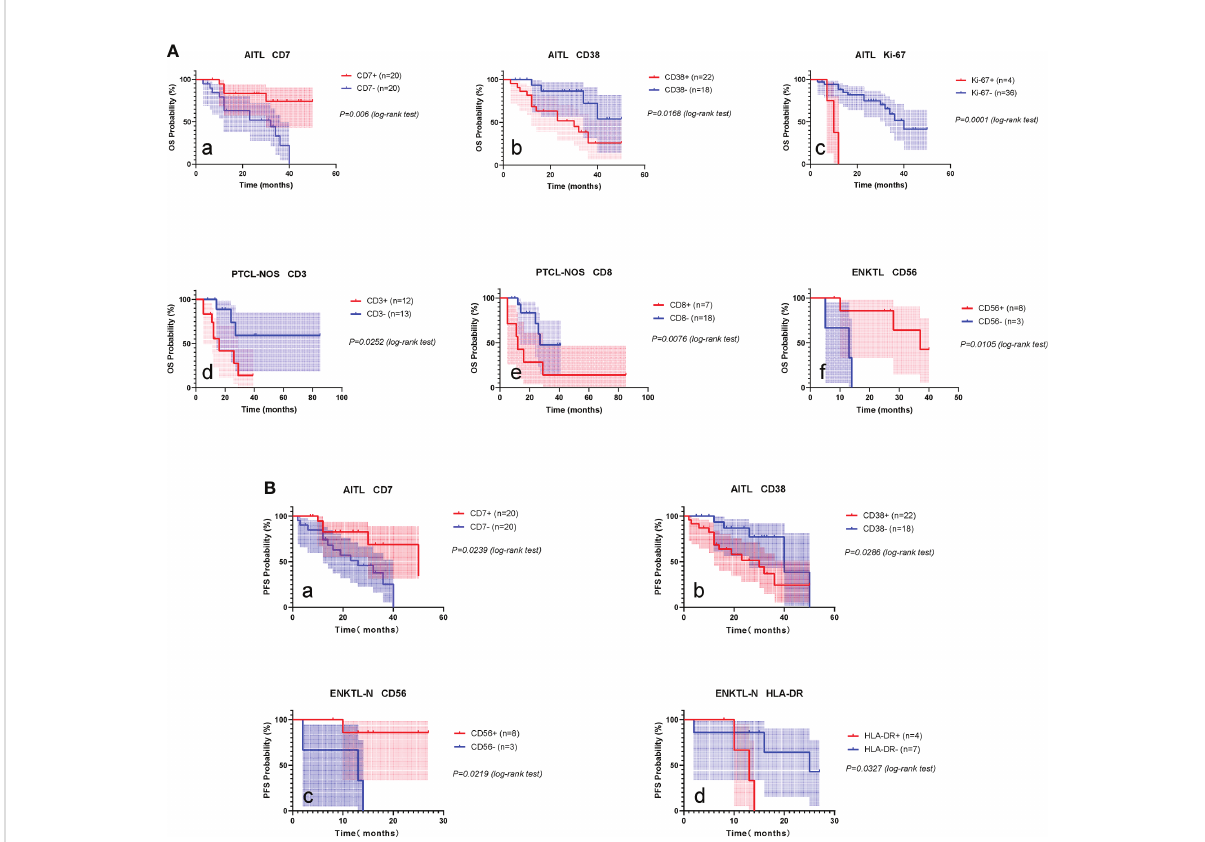
FIGURE 8 Prognostic markers of PTCLs. (A) Prognostic markers in fl uencing OS of AITL, PTCL-NOS, ENKTL-N. (a – c) , OS survival curves of CD7, CD38 and Ki-67 on AITL. (d, e) , OS survival curves of CD3 and CD8 on PTCL-NOS. (f) , OS survival curve of CD56 versus ENKTL-N. (B) Prognostic markers in fl uencing PFS in AITL and ENKTL-N. (a, b), PFS survival curves of CD7 and CD38 versus AITL. (c, d) , PFS survival curves of CD56 and HLA-DR against